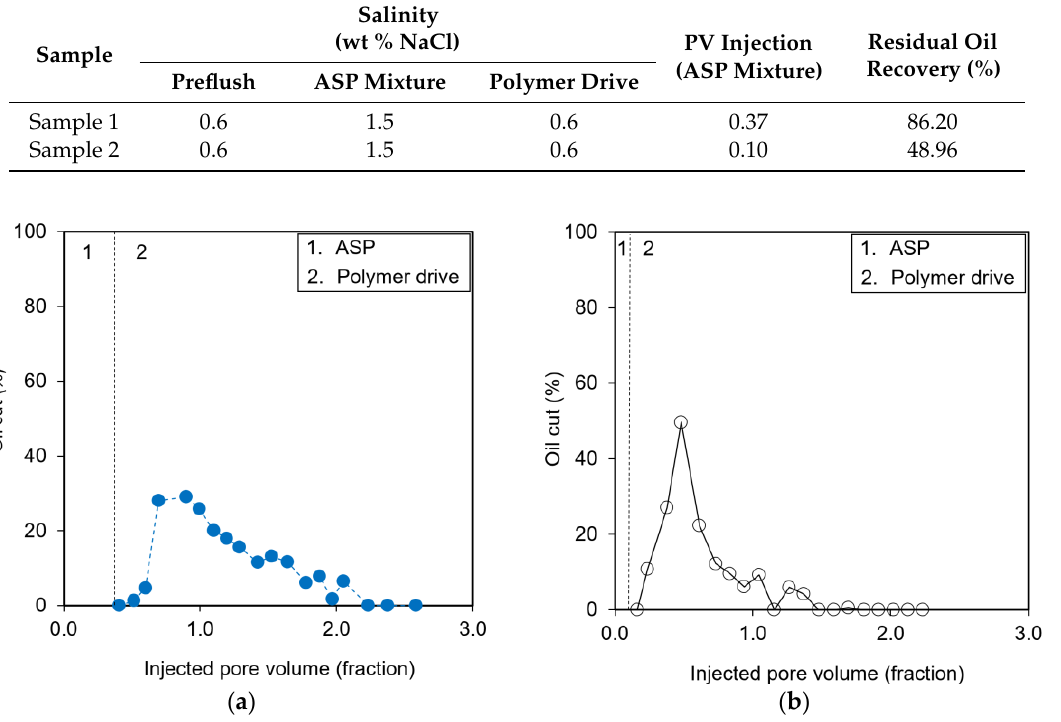
Figure 4. Performances of residual oil production (oil cut) implementing ASP flooding with different injection volumes of ASP slug: ( a ) an injected PV of 0.37 and ( b ) a PV of 0.10. The vertical dashed line represents the end of the ASP mixture injected into the core sample.